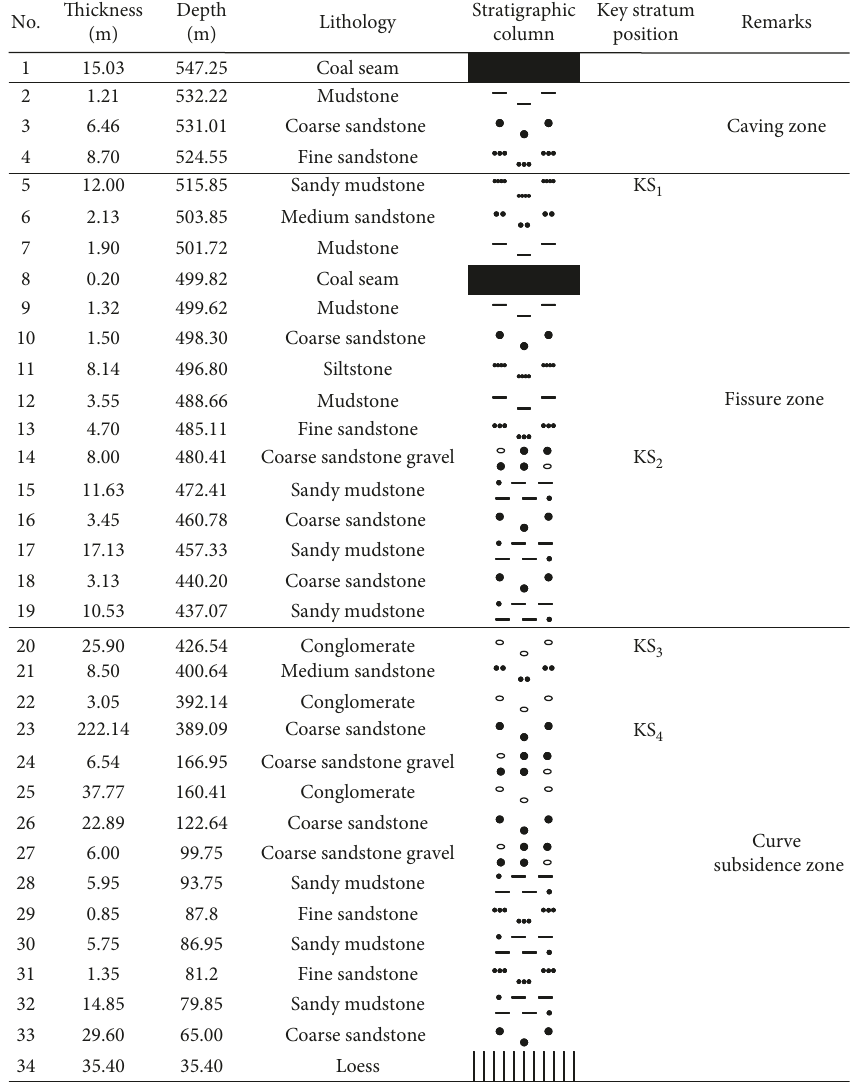
Figure 2: Location of the overburden KS in the Tingnan coal mine.